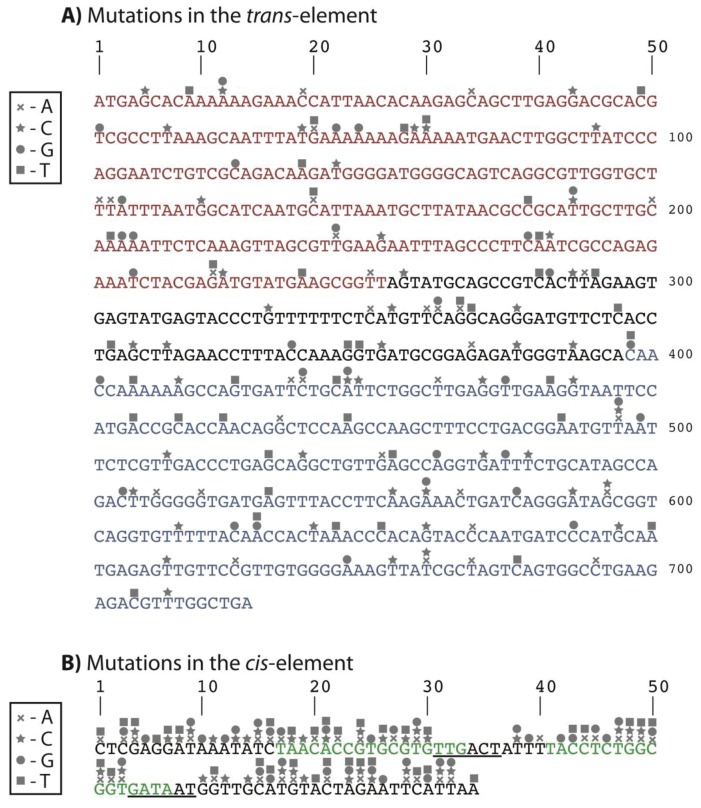
Identity and location of mutations in the double mutant library with a trans mutation that has no expression in the presence of CI, and a cis mutation with high expression in the absence of CI.(A) DNA sequence of the trans-element showing the N-terminal domain (red), C-terminal domain (blue), and the linker region connecting the two domains (black). (B) DNA sequence of the cis-element showing the −35 and −10 RNAP recognition sites (from left to right, underlined), and the two CI repressor operators (green). Unlike the double mutant library shown in Figure 3, where each double mutant had a unique mutation in cis and trans, in this library some cis mutations had to be repeated, as we could not identify 150 mutations in cis that had high expression in the absence of CI.